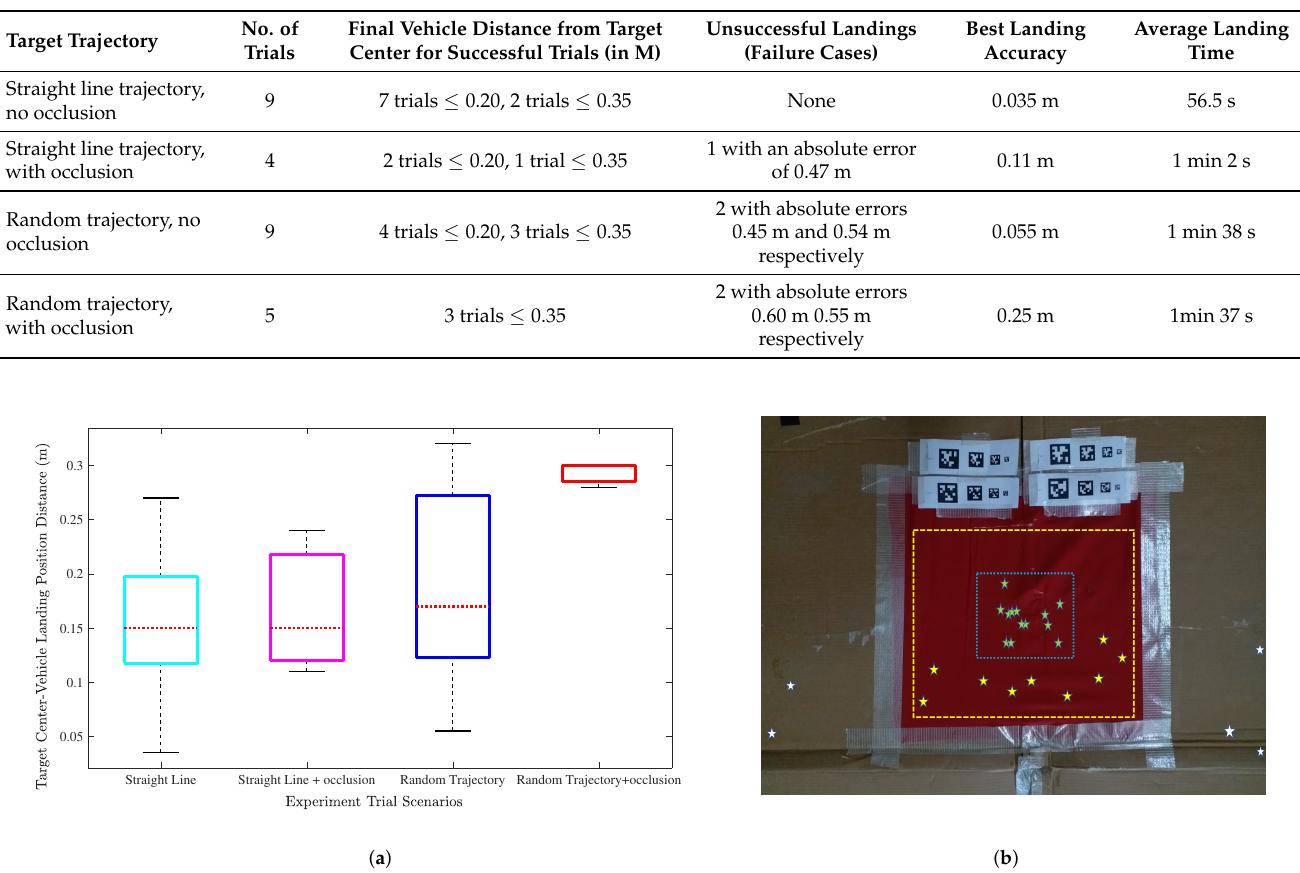
Figure 18. ( a ) Box plot of successful experiment trials for different target trajectory cases. ( b ) Depiction of vehicle landing position in different experiment